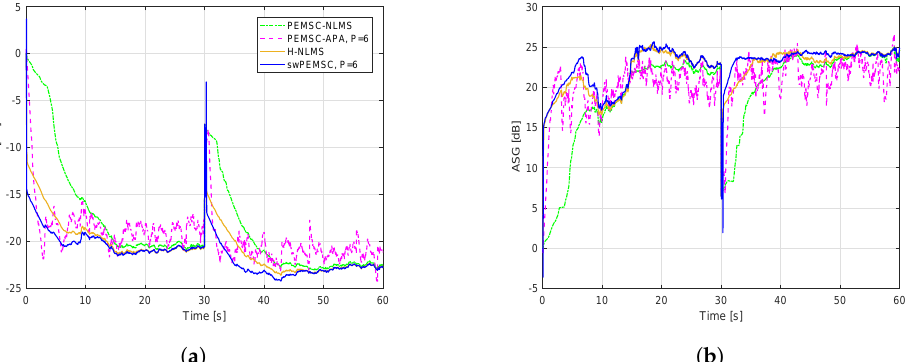
Figure 11. Compare performance of the proposed method with state-of-the art AFC methods using speech input, a sudden change of the feedback path from free-field (F 1 ) to telephone-near (F 2 ) after 30 s: ( a ) MIS; ( b )